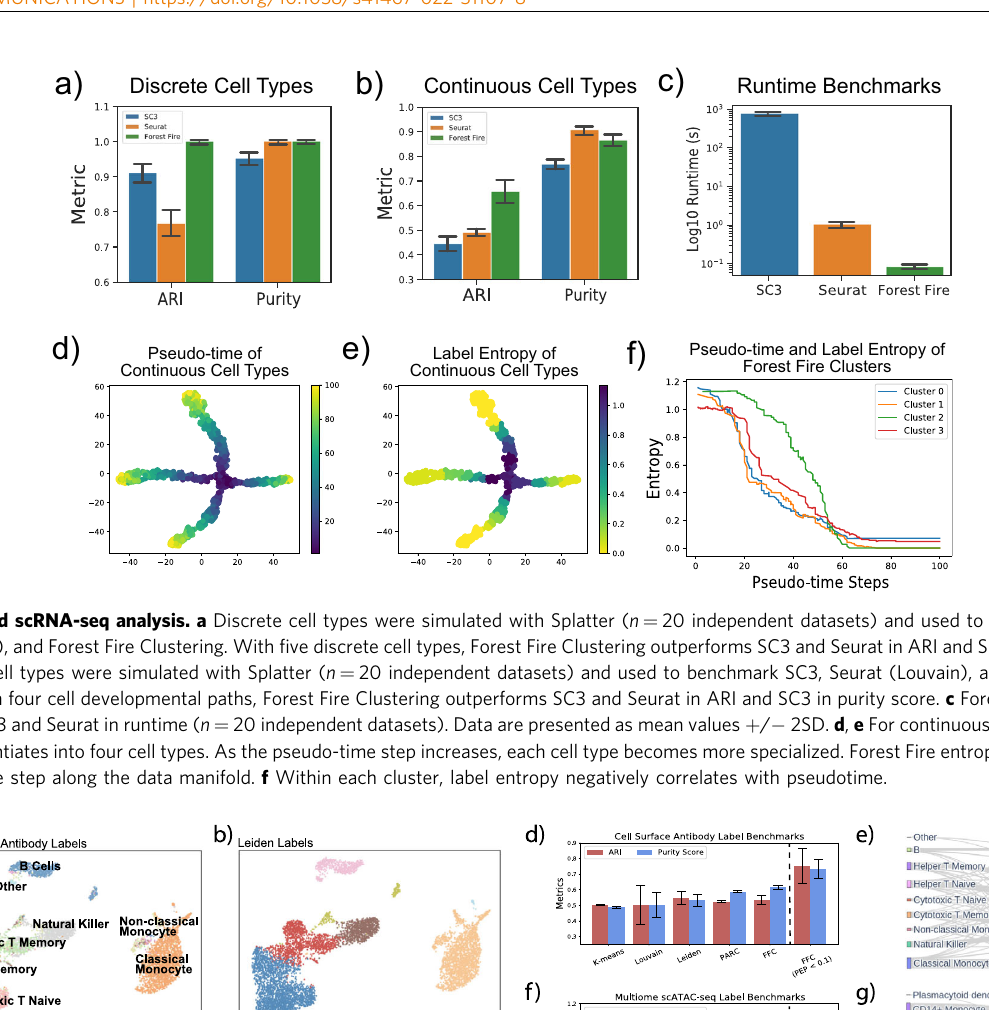
mental days 28 (Supplementary Fig. 13). Therefore, our method can naturally uncover branching points along developmental trajectories and reveal new biological insights from single-cell sequencing.